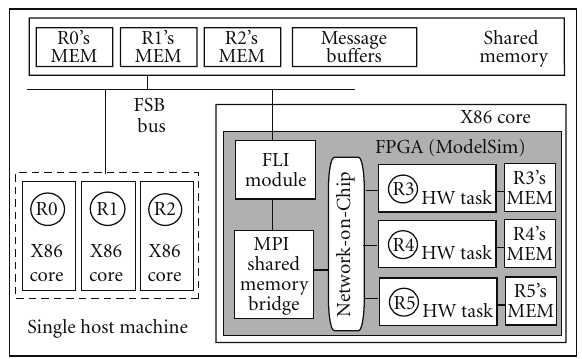
Figure 4: Simulation scheme for the sample application. One X86 core runs ModelSim with the FLI module for shared memory.